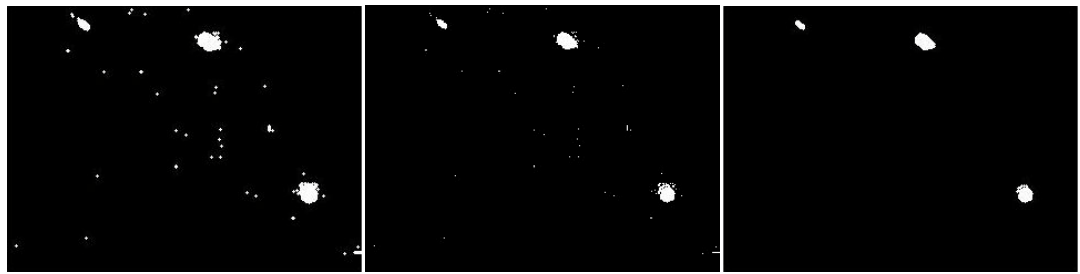
Figure 6. Left, the application of the Matlab dilution algorithm; Middle, normal; Right the application of the erosion